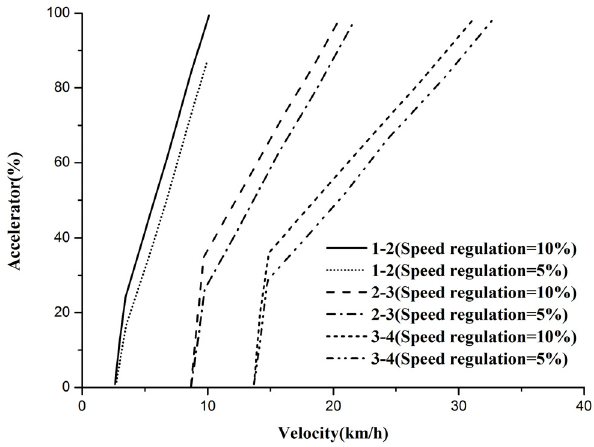
Figure 12. Economic shift schedules with different speed